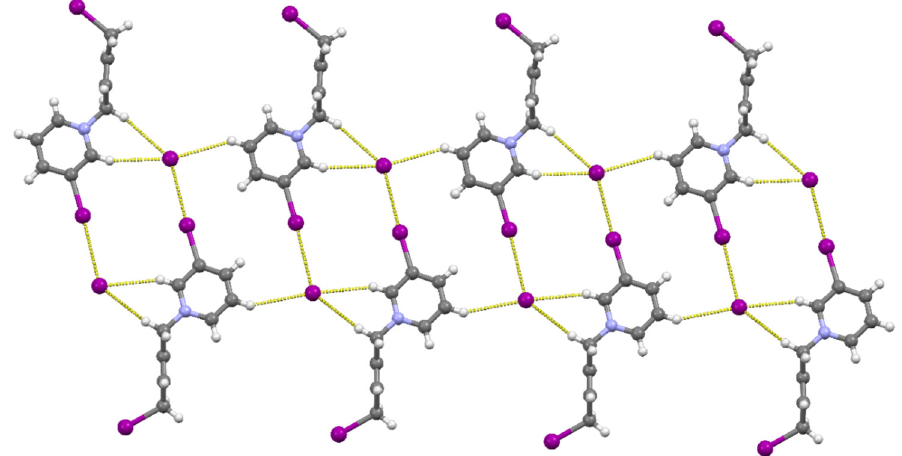
Figure 8. [ N -I Buen -( 3-IPy )] + cations and iodide anions connected through C − I · · · I − halogen and C − H · · · I − hydrogen bonds in cyclical [ N -I Buen -( 3-IPy )] 2 I 2 tetramers linked via C − H · · · I − hydro- gen bonds into chains the structure of [ N -I Buen -( 3-IPy